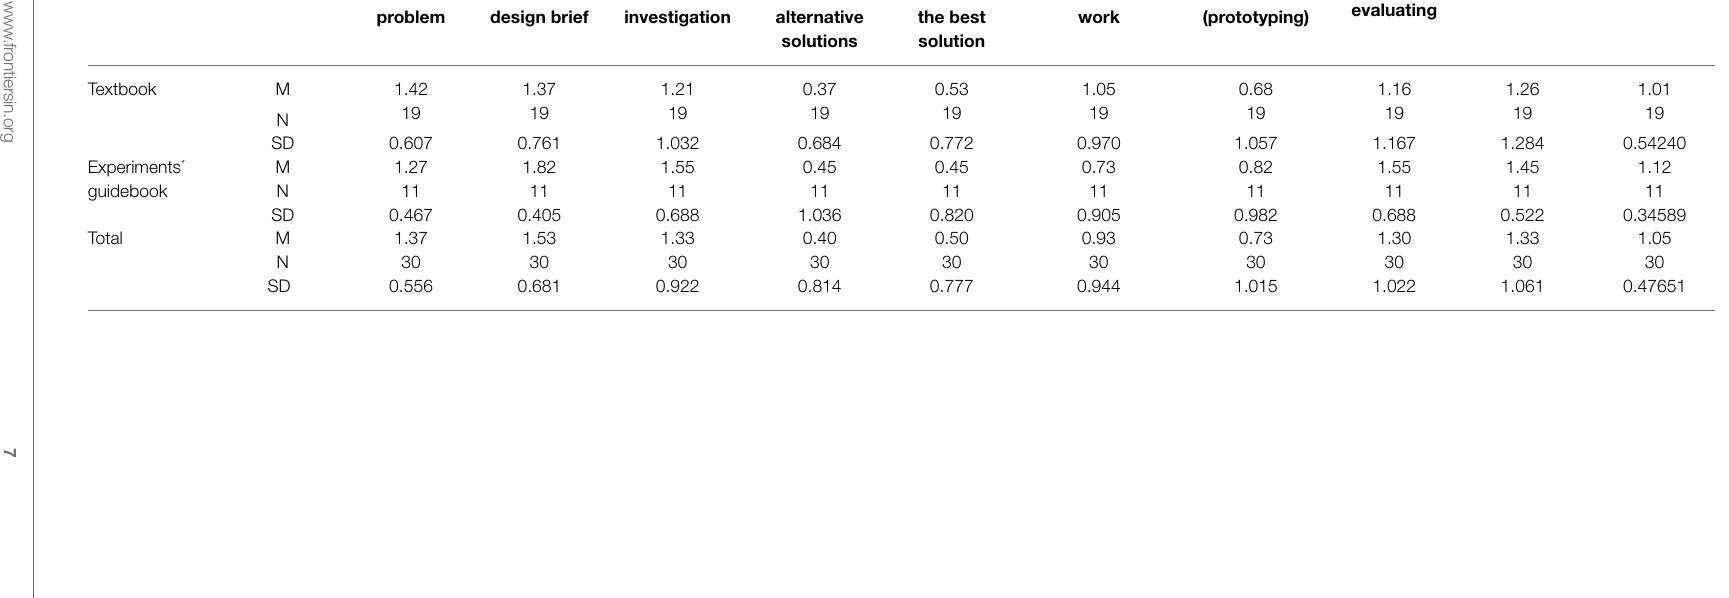
TABLE 4 | Means and standard deviations on the extent of the inclusion of The 9 EDP in both the student’s textbook and experiment guidebook. Book type Identify the